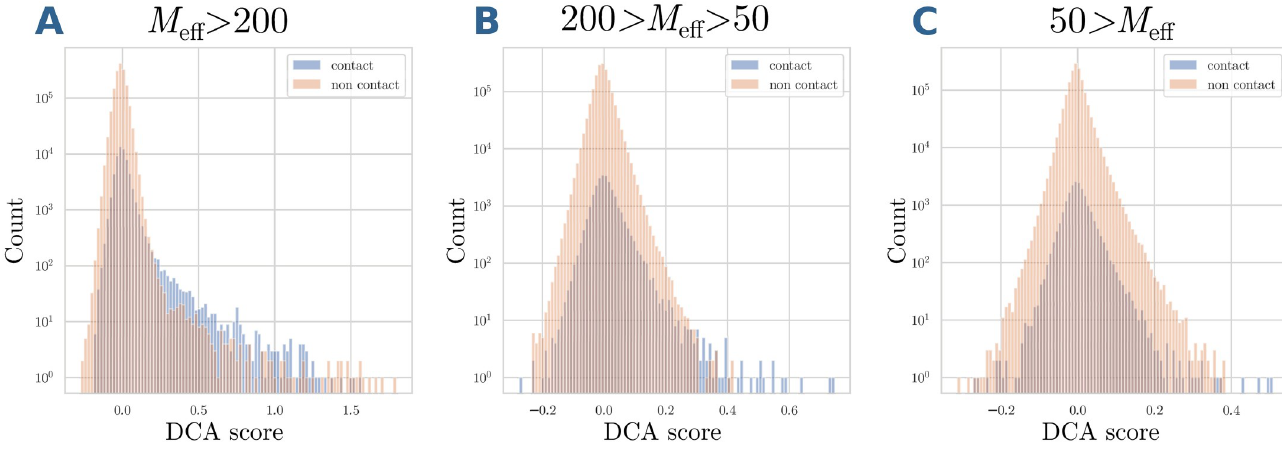
Fig 12. The distributions of DCA scores of contacts and non-contacts. For MSAs with M eff > 200 (Panel A) and 50 < M eff � 200 (Panel B). Note that the enrichment of true positive predictions (contacts) is very high in the tail of large DCA scores. In fact, the majority of the pairs with DCA score larger than 0.3 corresponds to contacts. This is not the case for MSA with M eff < 50 (Panel C), where the two distributions completely overlap.